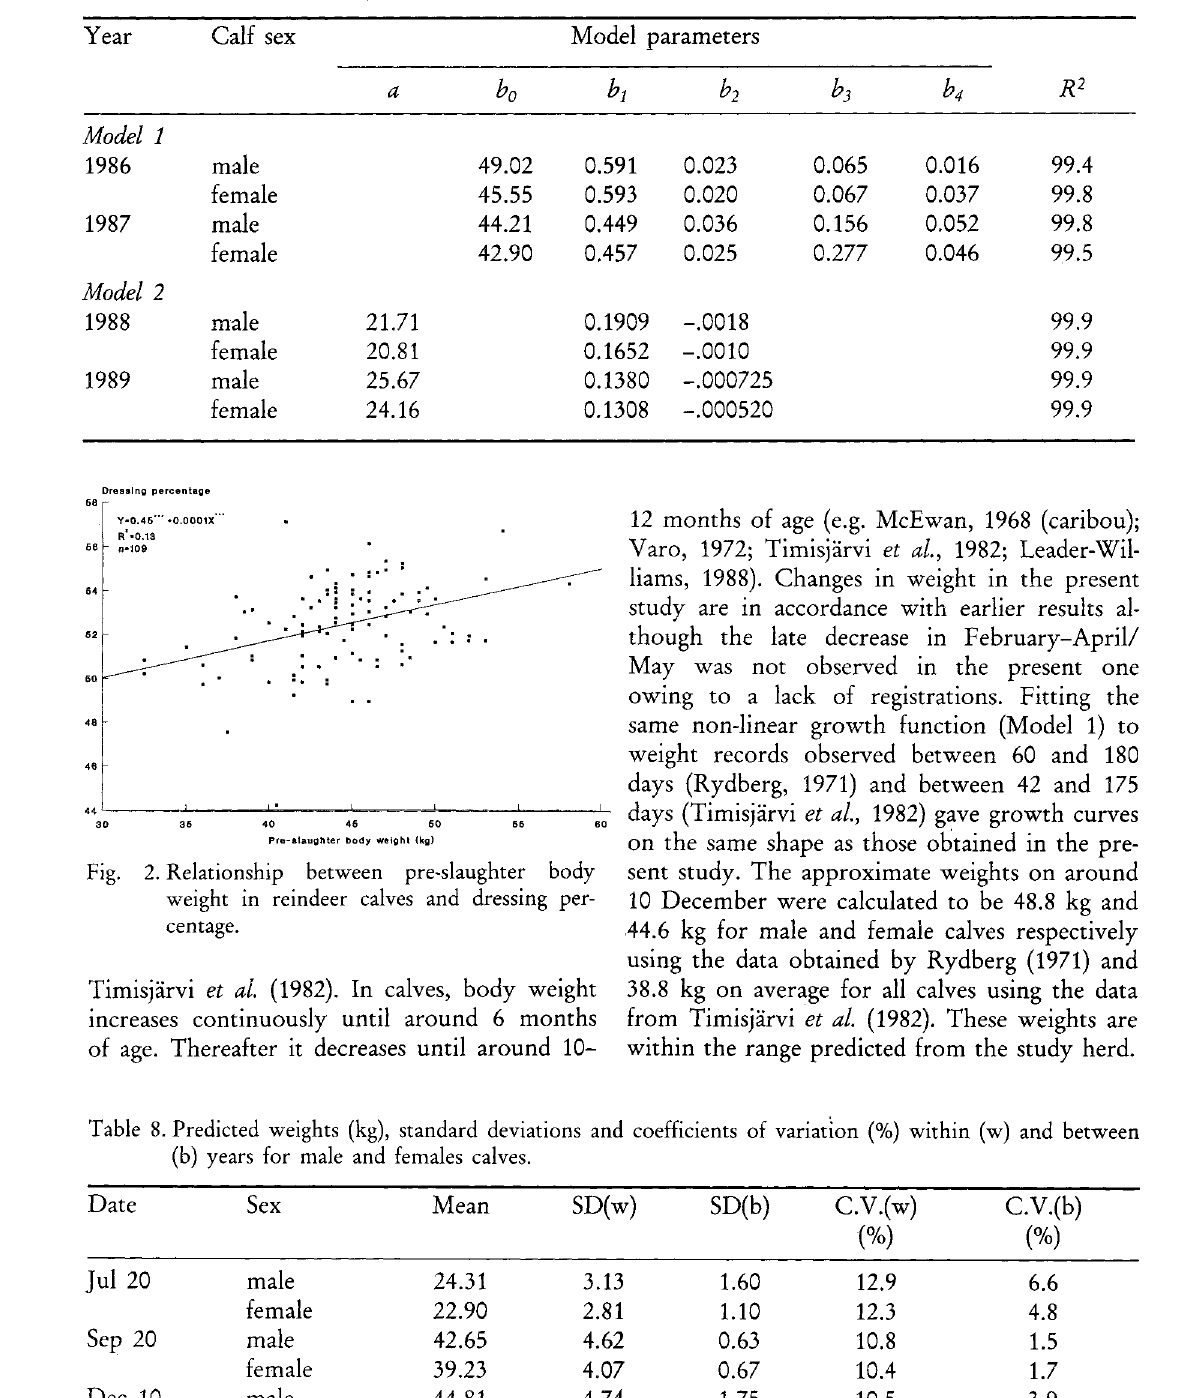
Table 8. Predicted weights (kg), standard deviations and coefficients of variation (%) within (w) and between (b) years for male and females calves.